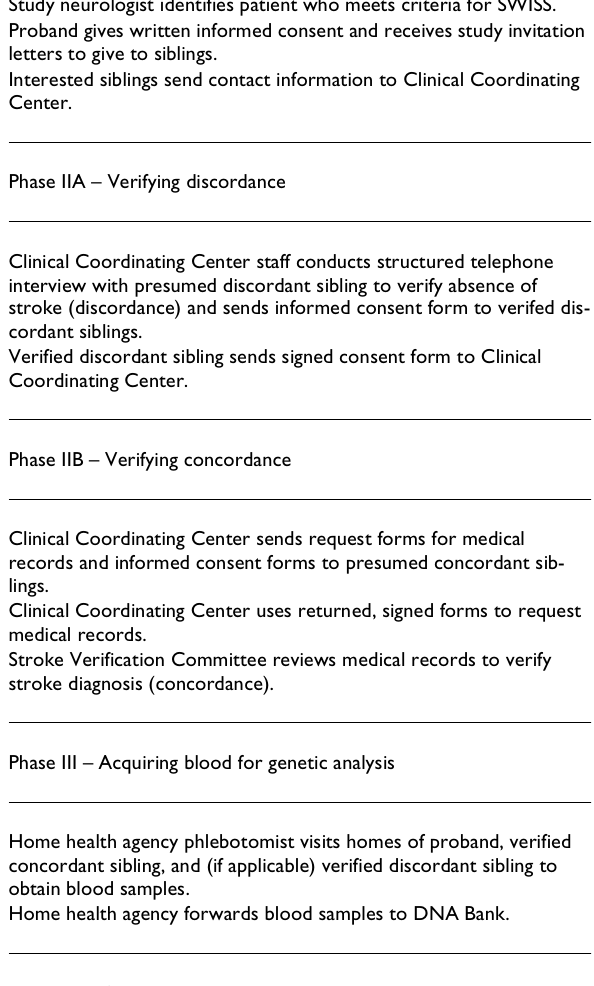
Table 2: Summary of Study Procedures Phase I – Enrolling probands and recruiting siblings